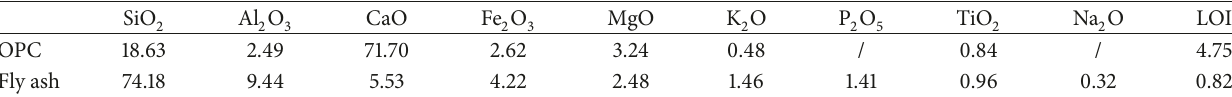
Table 2: Chemical compositions of OPC and fly ash.